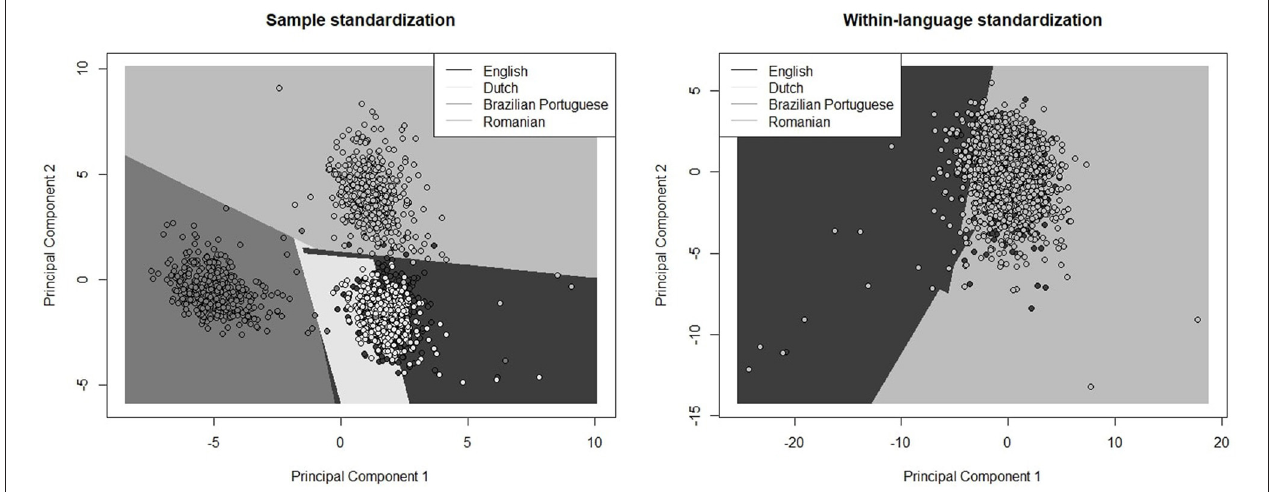
FIGURE 1 | The performance of the SVM in estimating the language of the transcripts based on all LIWC2015 categories after grand mean standardization (image on the left) and within-language standardization (image on the right). The results were obtained on the test subset.